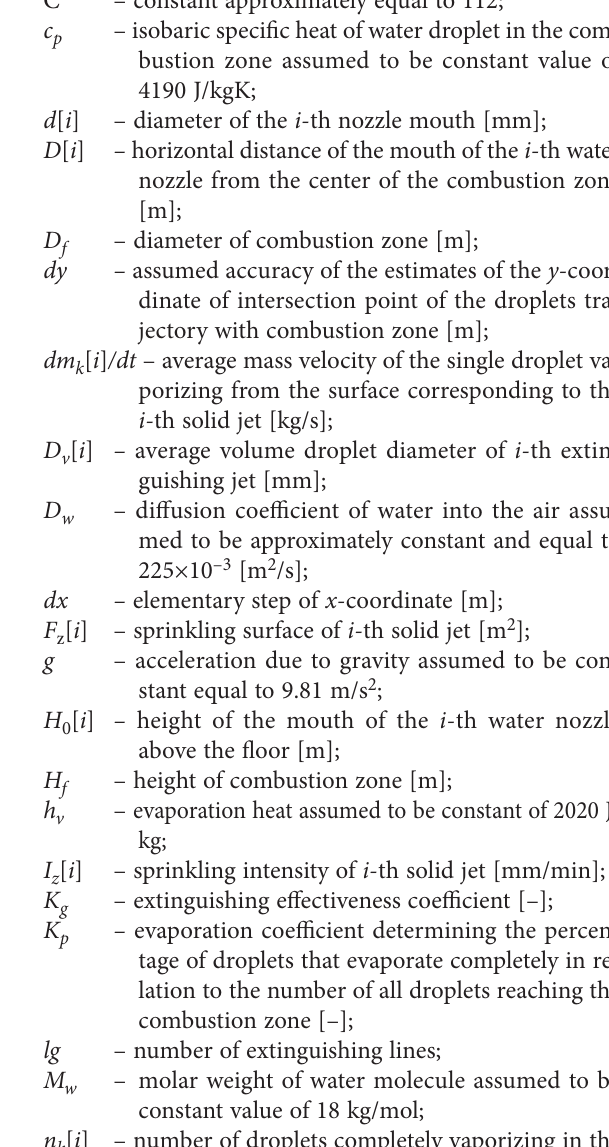
Figure 7. Heat received by drops vs nozzle output for two different inclination